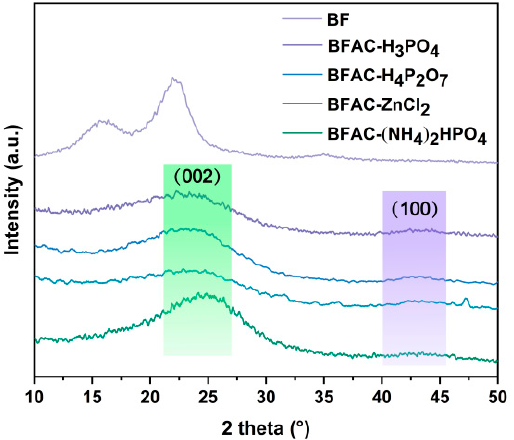
Figure 5. X-ray diffraction patterns of BFACs activated by different activators and BF. Table 2. BFACs crystal structure parameters. (L c ) Gaphite accumulation height, (L c /d 002 ) number of graphite stacking layers.